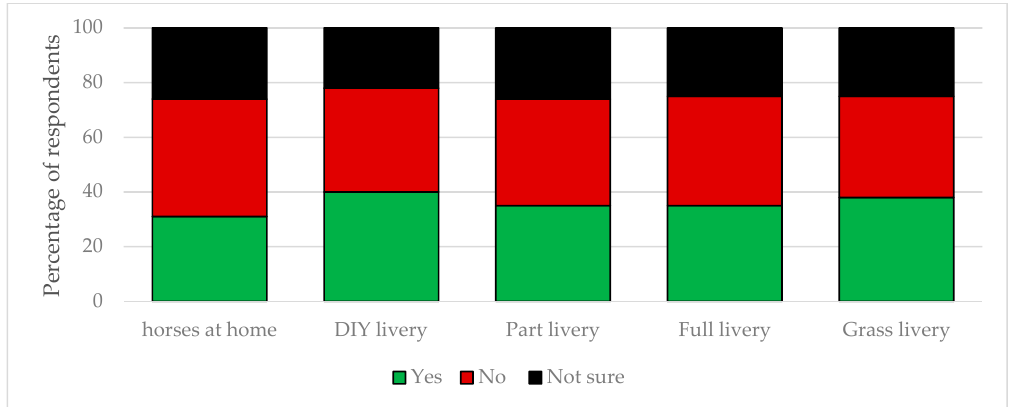
Figure 5. Percentages of horse owners who were concerned that the ongoing impacts of COVID-19 would make it di ffi cult for them to provide for their horse’s essential needs. Respondents were asked to state if they thought the impact of COVID-19 pandemic would a ff ect their ability to provide their horse / s essential management exercise and health requirements, if it would not a ff ect this, or if they were not sure at this stage if there would be an impact. The data are reported by establishment